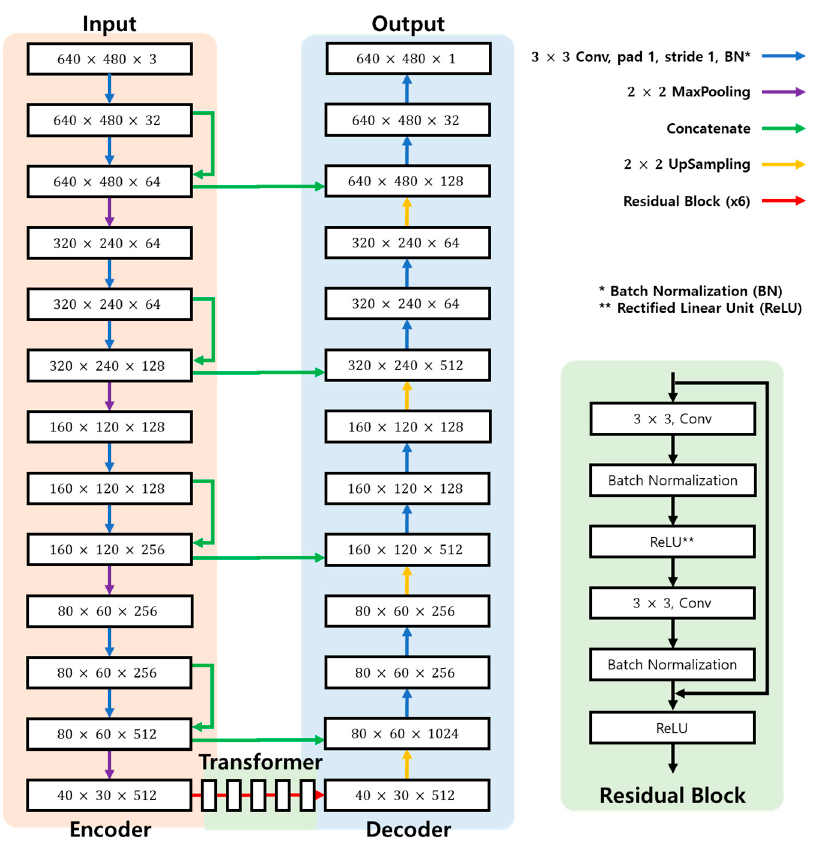
Figure 3. Structure of the generator applied in this study.